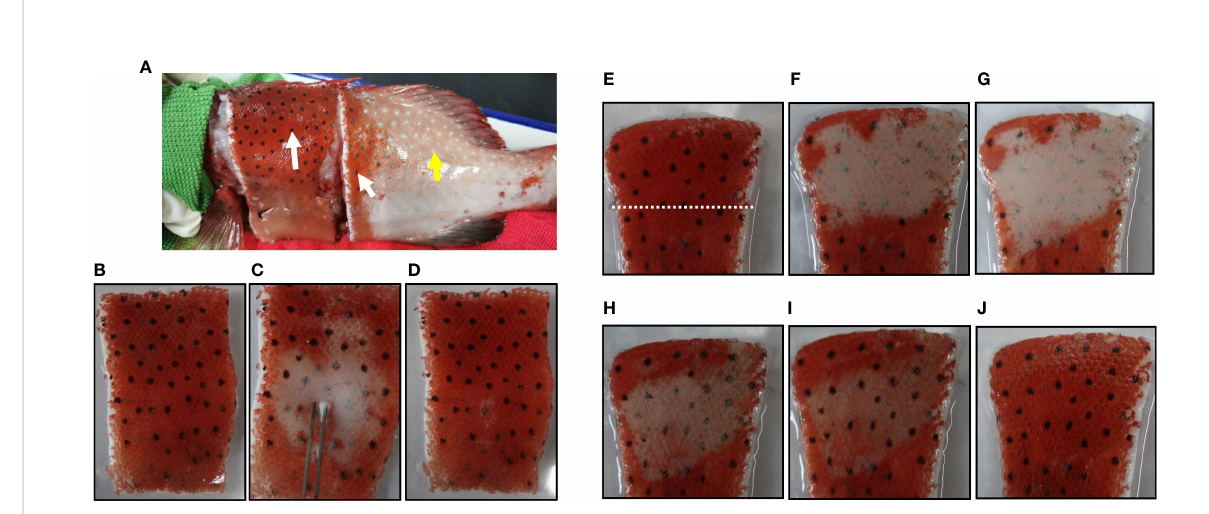
FIGURE 6 Photographs (taken with a camera) showing the spots on the excised skin and their responses to electrical stimulation, norepinephrine or forskolin. (A) Black spots on and around the excised skin (white arrows) and blue spots elsewhere (yellow arrow). (B) Equilibrated in physiological saline. (C) 15 sec after the electrical stimulation. (D) 1 min after the cessation of electrical stimulation. (E) Equilibrated in physiological saline. 10 m M NE is applied to the area above the white dashed line and the lower part is used as a control. (F) 3 min after the treatment of NE. (G) 5 min after the treatment of NE. 100 m M forskolin was applied directly to the area where the color has changed. (H) 1 min after the treatment of forskolin. (I) 2 min after the treatment of forskolin. (J) 10 min after the treatment of forskolin.